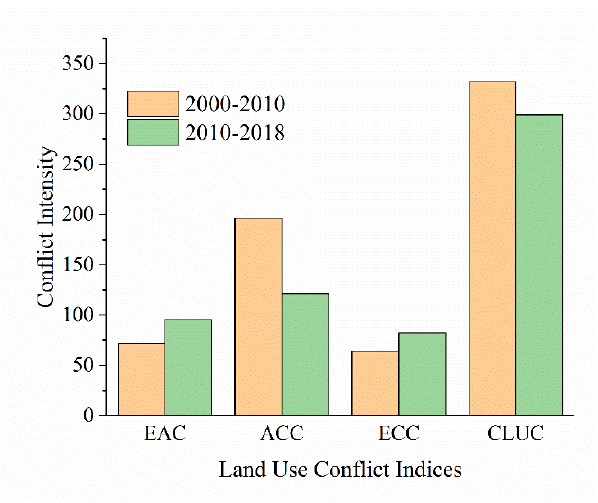
Figure 3. Variation of the average conflict indices of